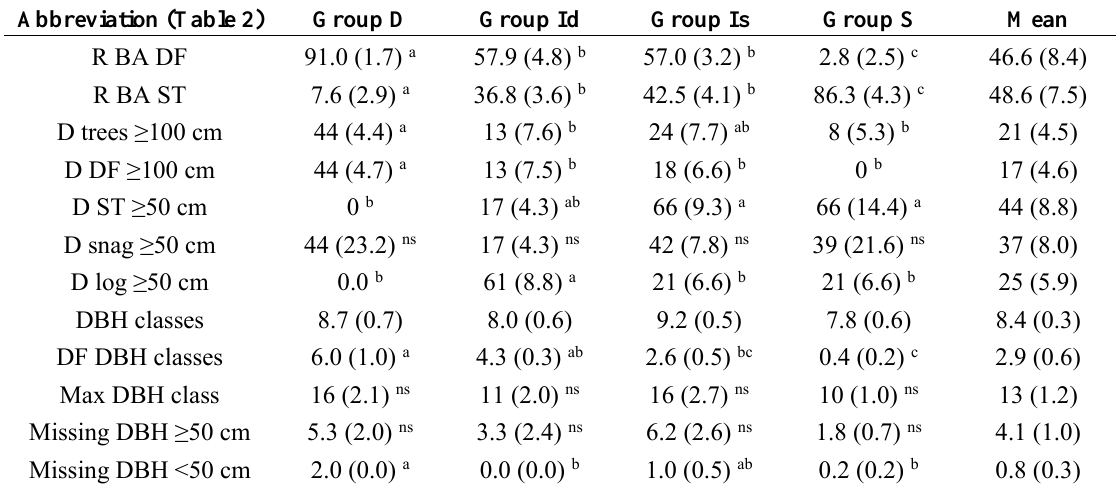
Table 4. Mean values of variables in groups shown in Table